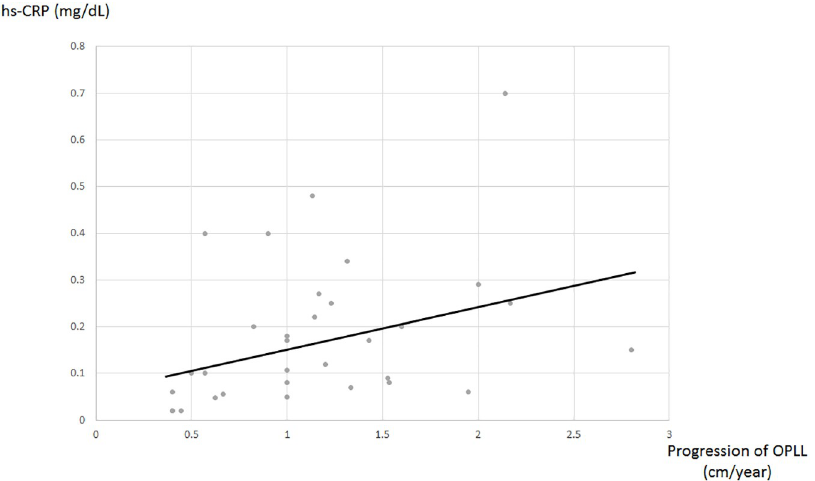
Fig 3. The relationship between the averagelength of OPLL progression per year and the serum concentration of hs-CRP in the OPLL group. A weak positive correlationwas found. The data showed statistical significance(p = 0.045, r =